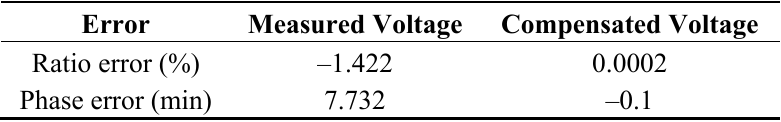
Figure 7. Results for Case 1: ( a ) v 1 (solid) and av 2 (dotted); ( b ) av s ; ( c ) i 0 (solid), i m (dotted), and i c (dashed); ( d ) i 1 (solid), i 0 (dotted), and i 2 /a (dashed); ( e ) v p ; and ( f ) v 1 (solid), av 2 (dotted), and v comp (dashed). Table 2. Errors for 120% of the rated